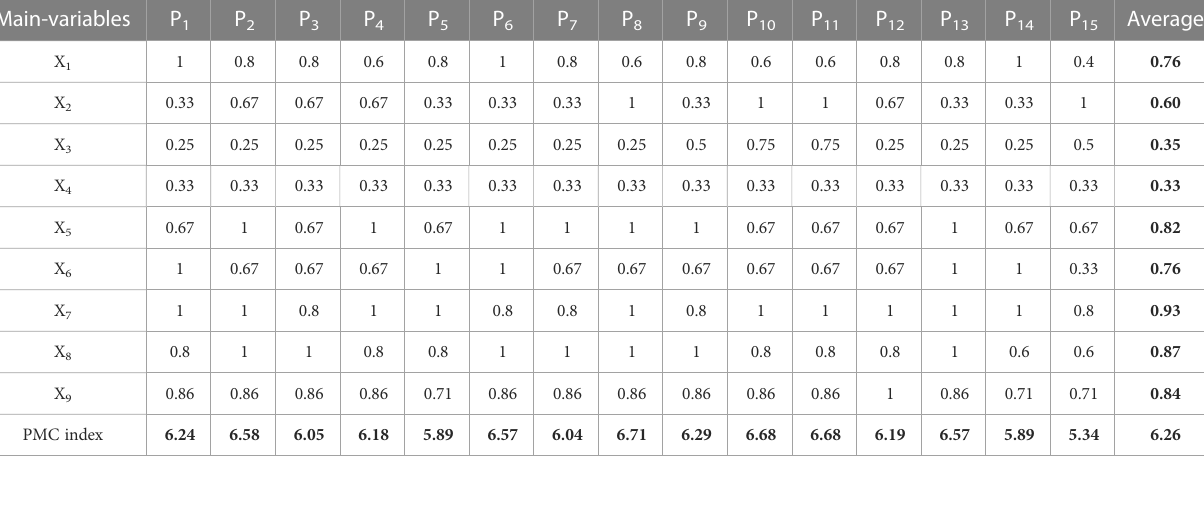
TABLE 5 Evaluation criteria for policy consistency based on PMC index scores.